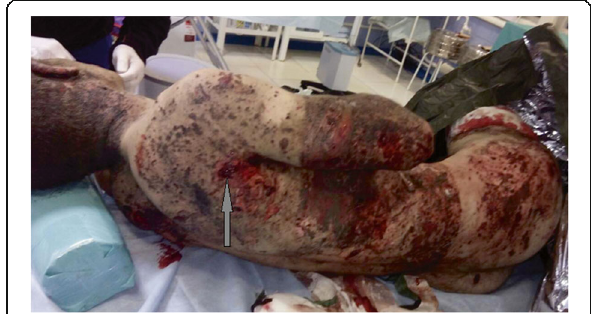
Fig. 1 Presentation of the combat patient after being injured by multiple-launch rocket system “ Grad ” (first hours after